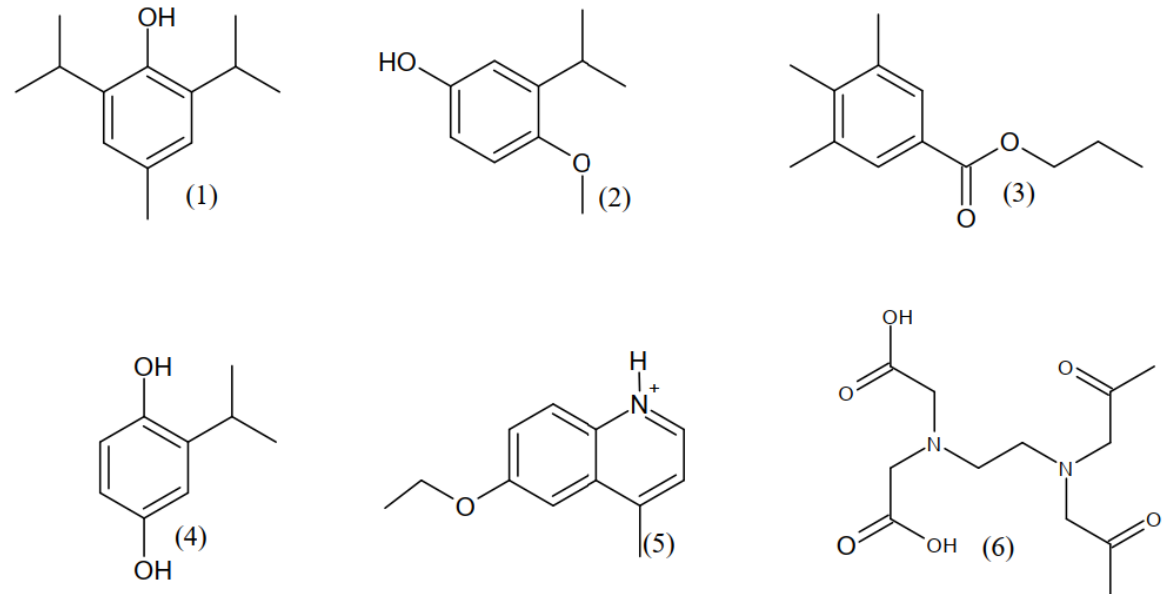
Figure 3. Molecular structures of industrial synthetic antioxidants. (1) Butylated hydroxytoluene (BHT), (2) butylated hydroxyanisole (BHA), (3) propyl gallate (PG), (4) tert -butylhydroquinone (TBHQ), (5) ethoxyquin and (6) ethylenediaminetetraacetic acid